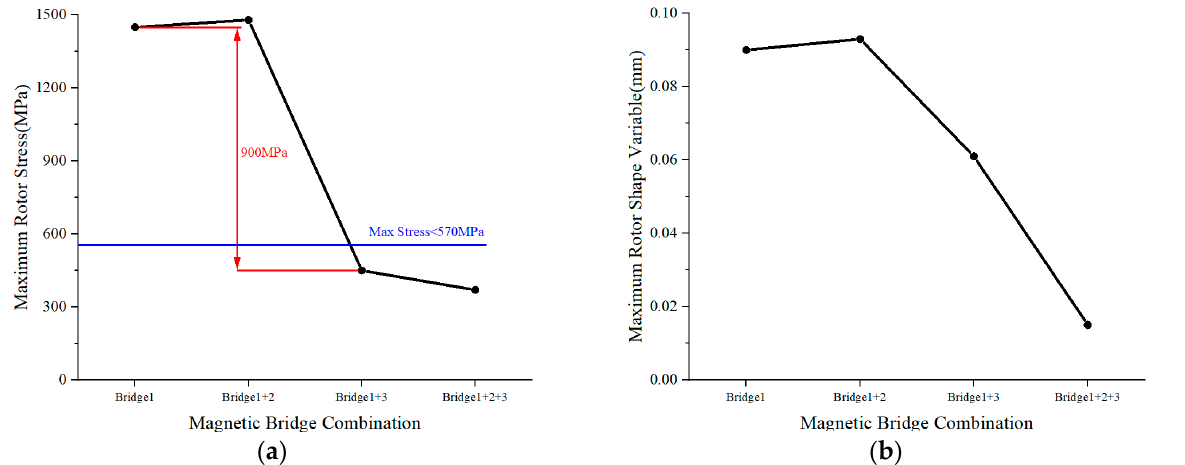
Figure 10. Rotor stress with different magnetic bridge combinations at maximum speed conditions: ( a ) rotor maximum von Mises stress, ( b ) rotor maximum deformation quantity.